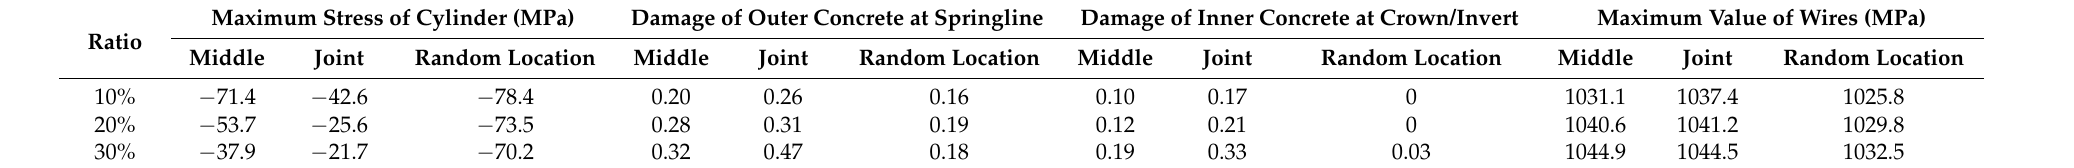
Table 8. The main analyzing index value of pipe